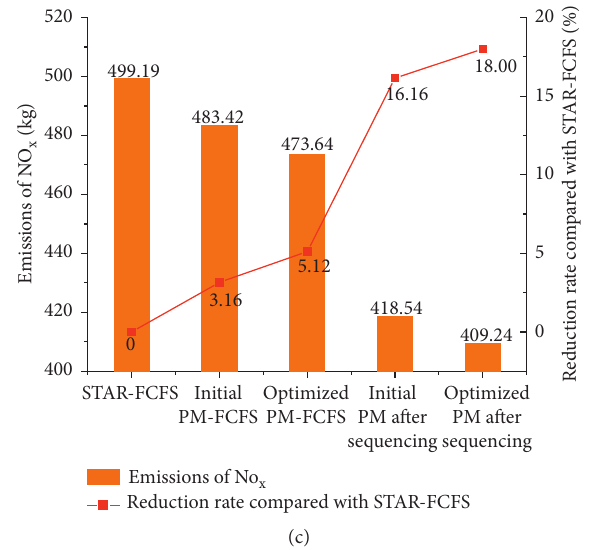
Figure 22: The emissions of three pollutants. (a) CO. (b) HC. (c) NO